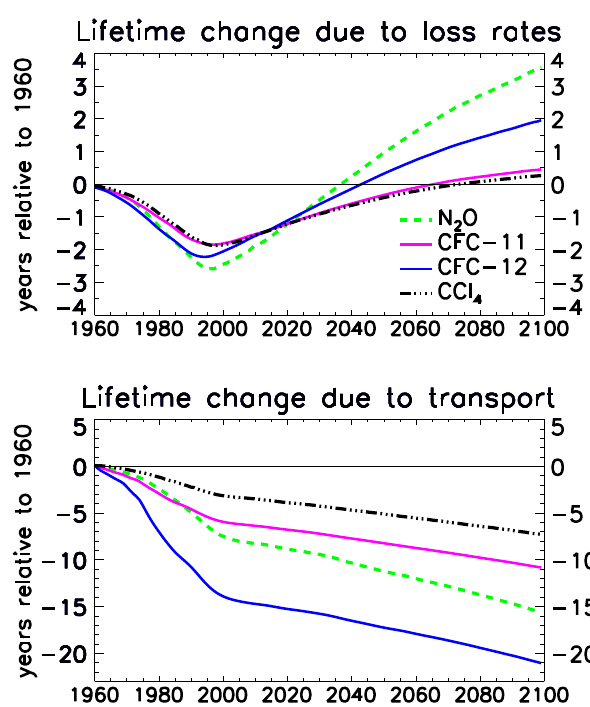
Fig. 14. (Top) The difference between the base and fixed loss rate simulations (black lines minus red lines in Fig. 13), illustrating the lifetime changes due to the changing loss rates. (Bottom) The difference between the fixed loss rate and fixed chemistry and transport simulations (red lines minus green lines in Fig. 13), showing the lifetime changes due to changes in transport. Shown are results for N 2 O (green dashed), CFC-11 (pink solid); CFC-12 (blue solid), and CCl 4 (black dashed-dotted).